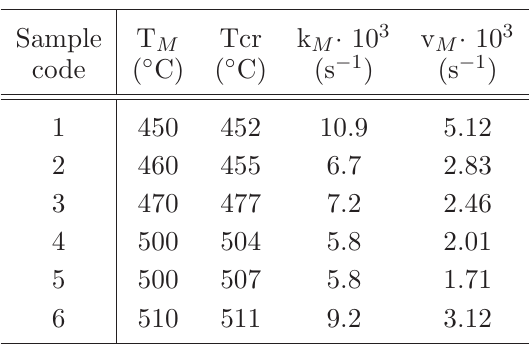
Table 5 Kinetic characteristics corresponding to the maximum degradation rate, on the tem- perature domain ∆T 2